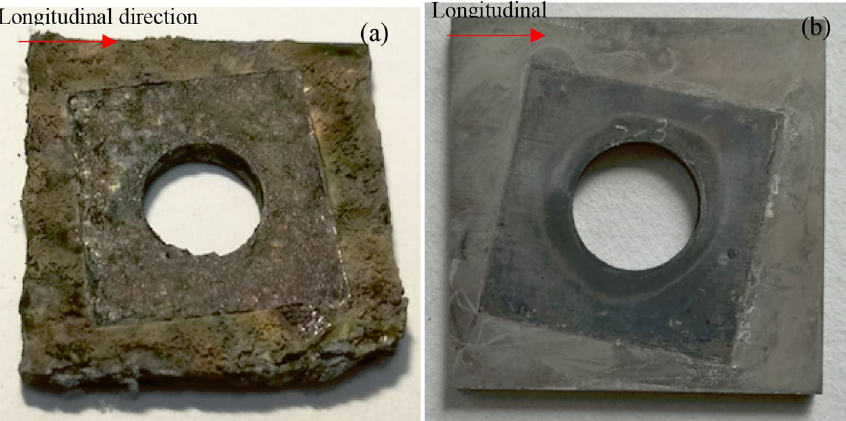
Figure 10. Surface morphologies of different titanium alloys after the crevice corrosion test: ( a ) Ti-6Al-4V, ( b )